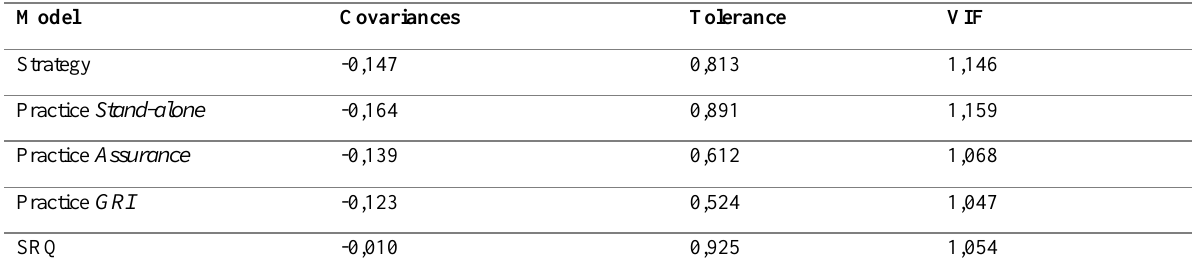
Table 8: Correlation coefficient of the independent variables of strategy, practice and